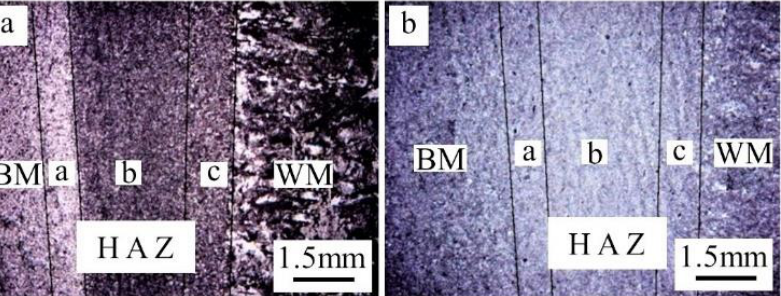
Figure 13. Metallographic structure of welded joints (amplification of Figure 12a) ( a ) before quenching and tempering treatment, and ( b ) after quenching and